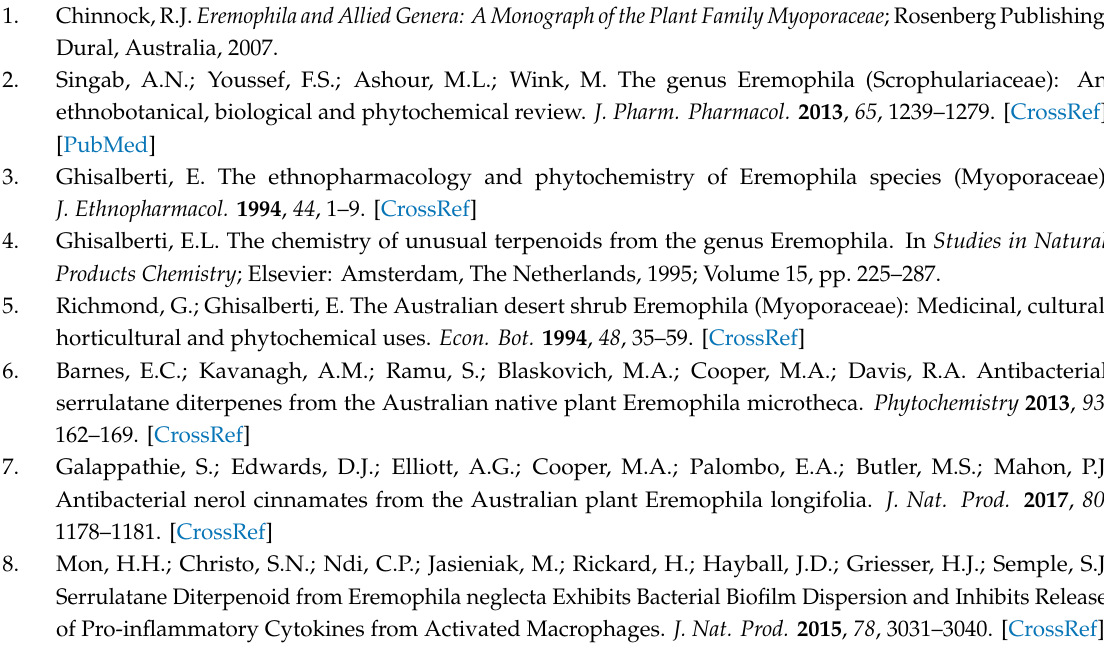
Figure S1: Eremophila lucida, flowering twigs and growth habit underneath Eucalyptus trees, Figure S2: 1H NMR spectrum of compound 1 in CDCl3, Figure S3: 13C NMR spectrum of compound 1 in in CDCl3, Figure S4: DEPT NMR spectrum of compound 1 in CDCl3, Figure S5: 1H-1H COSY NMR spectrum of compound 1 in CDCl3, Figure S6: HSQC NMR spectrum of compound 1 in CDCl3, Figure S7: HMBC NMR spectrum of compound 1 in CDCl3, Figure S8: 1H NMR spectrum of compound 2 in CD3OD, Figure S9: 13C NMR spectrum of compound 2 in in CD3OD, Figure S10: 1H-1H COSY NMR spectrum of compound 2 in CD3OD, Figure S11: HSQC NMR spectrum of compound 2 in CD3OD, Figure S12: HMBC NMR spectrum of compound 2 in CD3OD, Figure S13: 1H NMR spectrum of compound 3 in CDCl3. Figure S14: 13C NMR spectrum of compound 3 in in CDCl3, Figure S15: 1H-1H COSY NMR spectrum of compound 3 in CDCl3, Figure S16: HSQC NMR spectrum of compound 3 in CDCl3. Figure S17: HMBC NMR spectrum of compound 3 in